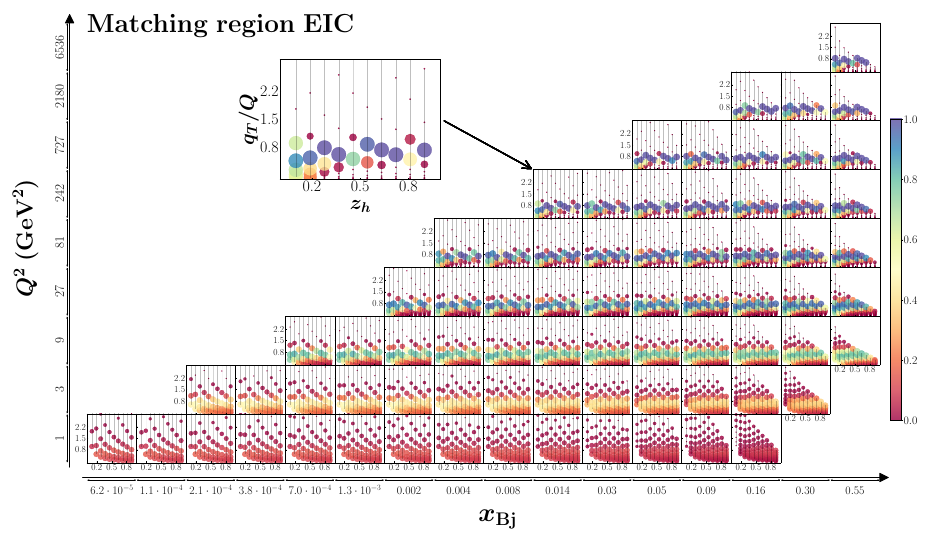
Figure 13 . Affinity for the TMD-collinear matching region for EIC kinematics. Bin centers are located in the points corresponding to the bin average values of x and q we plot the affinity as a dot with size proportional to the corresponding affinity value. T /Q Affinity is also color coded, according to the scheme on the right of the figure